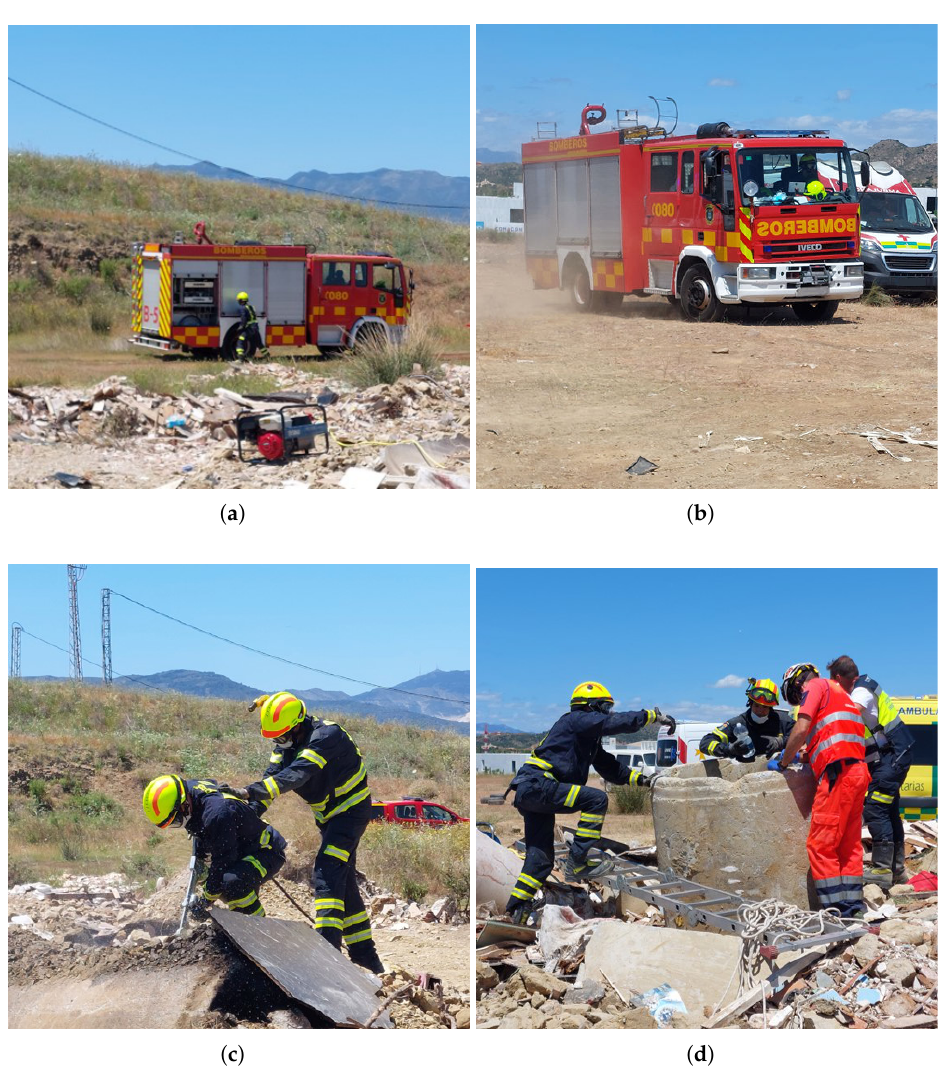
Figure 11. Sequence of the local recording exercise: ( a ) closing truck compartments; ( b ) driving the fire truck; ( c ) using cutting extinguisher; ( d ) Helping at well